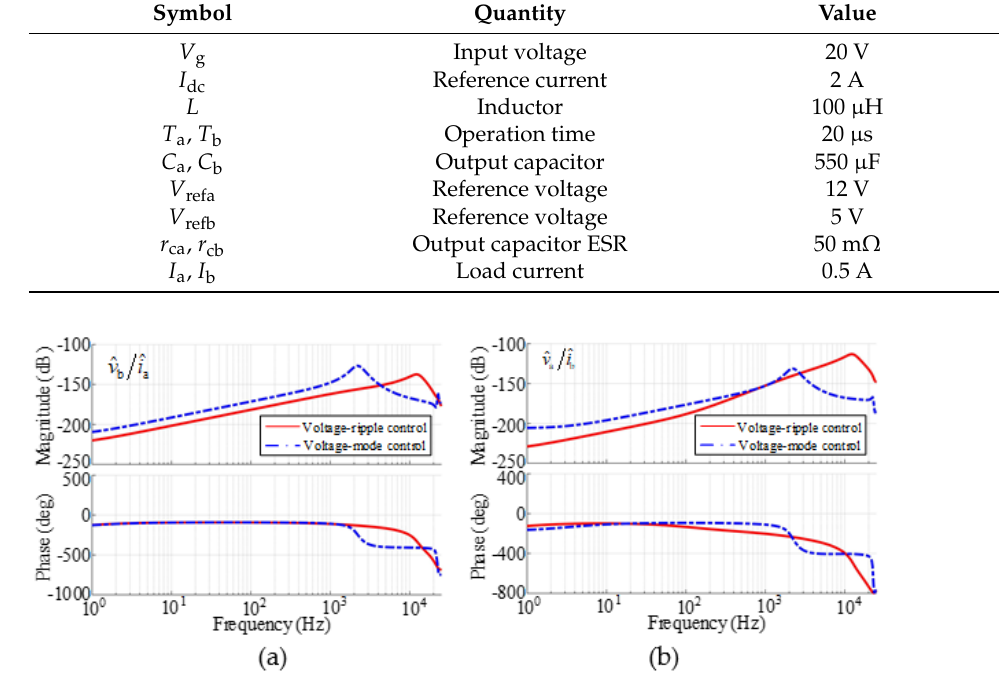
Figure 8. Bode plots of output impedance transfer functions under voltage mode-controlled and voltage ripple-controlled PCCM SIDO buck converters: ( a )